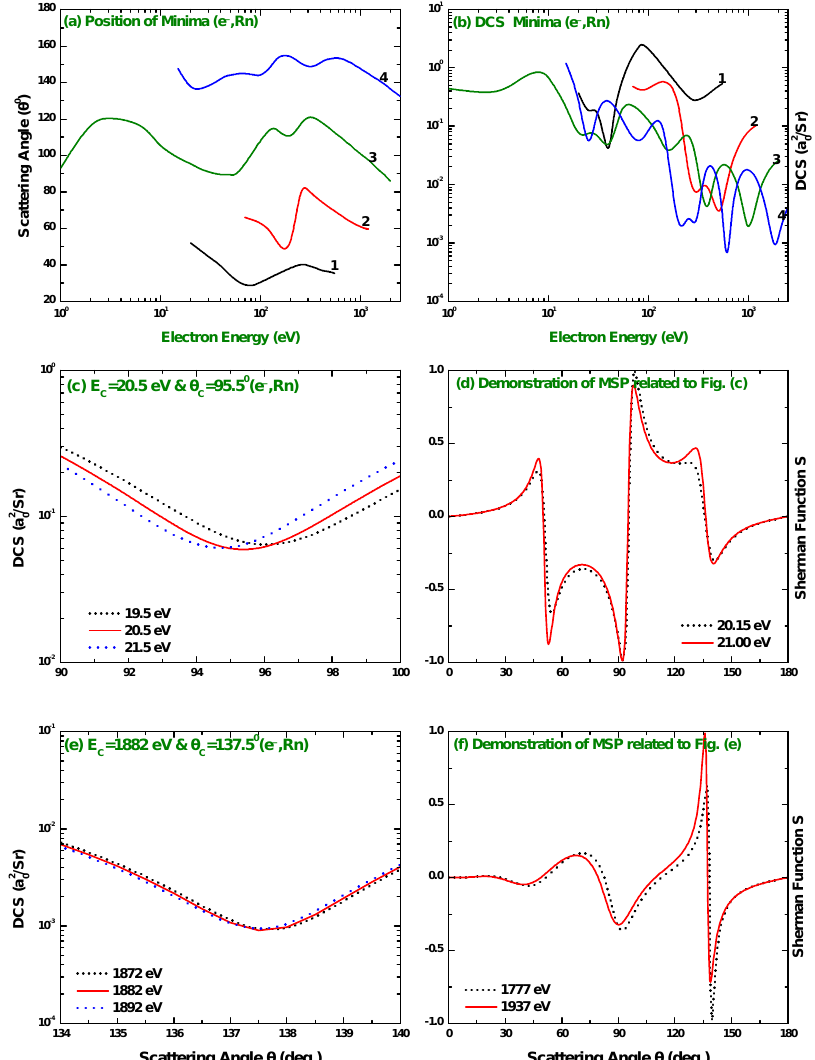
Figure 15. Energy dependence of the angular positions ( a ) and the DCS values ( b ) of the deep minima for electrons elastically scattered from neutral radon atoms. Furthermore, are presented the angular dependence of the DCS and S ( θ ) for some incident energies in the vicinity of the critical minimum at ( E c =20.5 eV, θ c = 95.5 ◦ ) ( c , d ) and ( E c =1882 eV, θ c = 137.5 ◦ ) ( e , f